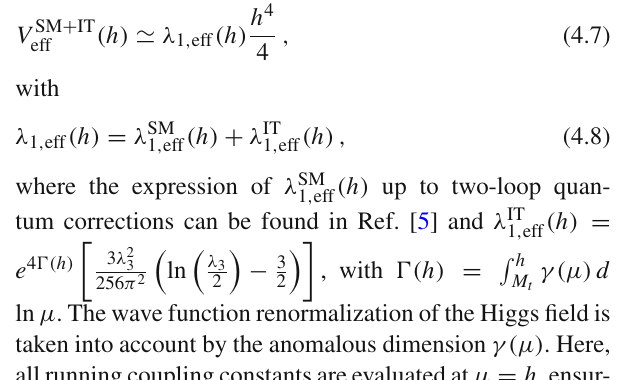
Table 1. For this benchmark point, we show the evolution